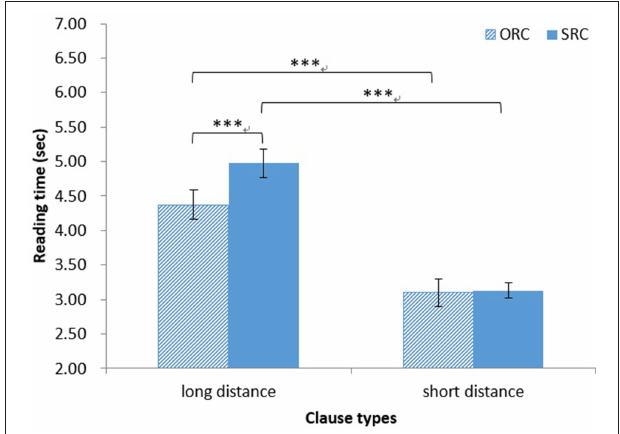
FIGURE 1 | Chinese group: reading time of full sentences. *** p < 0.001 .